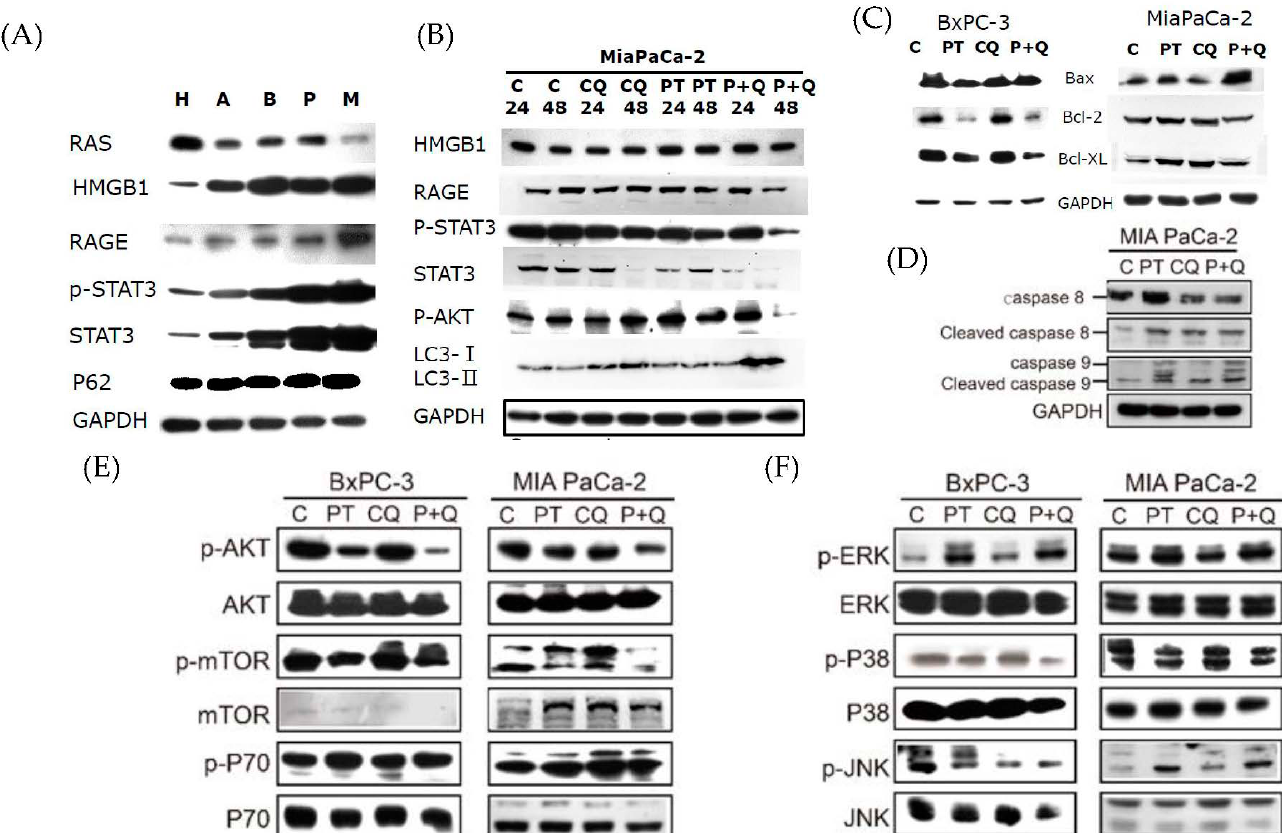
Figure 4. PT combined with CQ downregulates autophagy and the RAGE/STAT3 signaling pathways, leading to apoptosis: ( A ) The RAS, HMGB1, RAGE, p-STAT3, STAT3, and p62 protein expression in HPDE normal human pancreatic cells (H) and in AsPC-1 (A), BxPC-3 (B), PANC-1 (P), and MIA PaCa-2 (M) pancreatic cancer cells. ( B ) The effects of CQ and PT